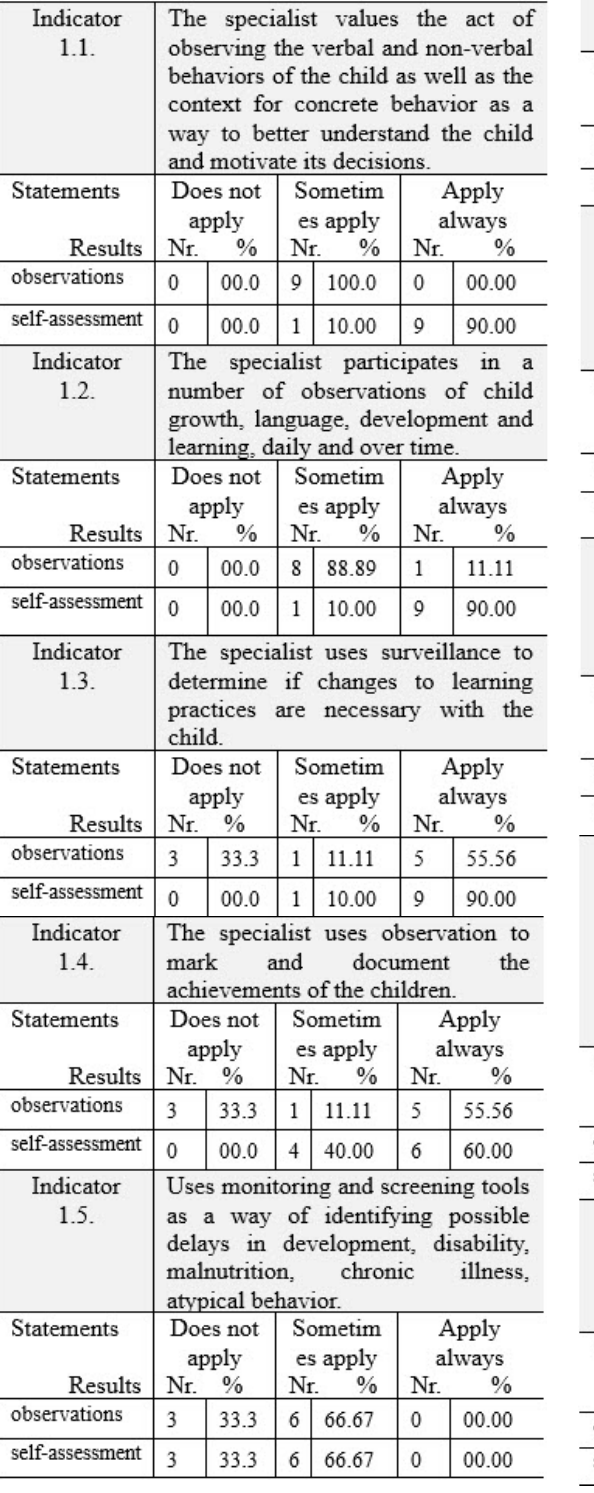
Table 22. Principle 1: Monitoring pro - vides important information about child de - velopment, learning, interests, strengths and needs.